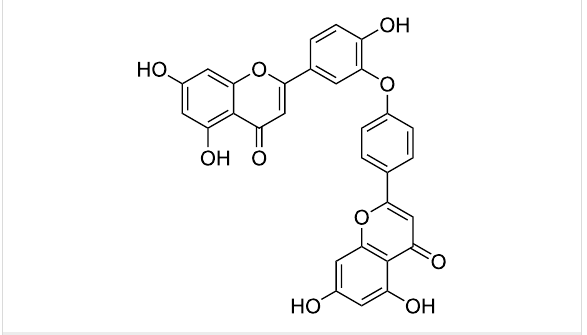
Figure 1: Structure of ochnaflavone ( 1 ).